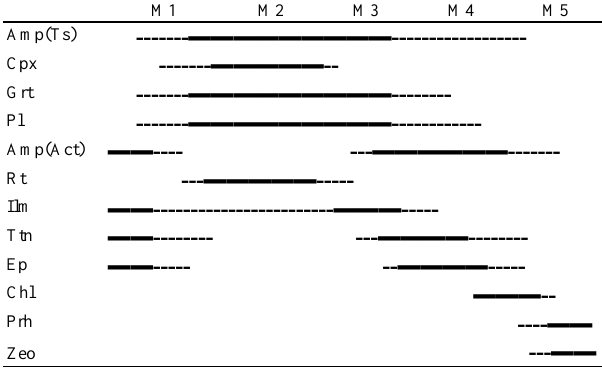
Table 2. Relations between metamorphic stage and mineral growth in the Sabzevar granulites.